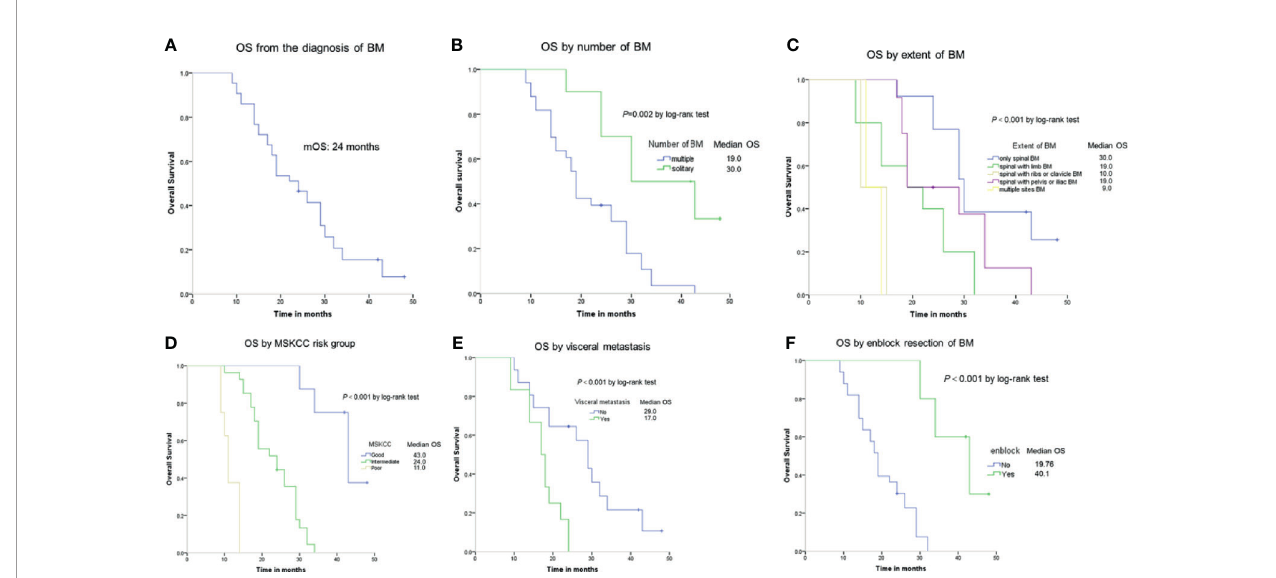
FIGURE 2 | Kaplan-Meier estimates of overall survival (OS) among RCC patients with spinal BM (A) and the OS according to number of sBM (B) , extent of sBM (C) , MSKCC risk group (D) , visceral metastasis (E) , and en-block resection (F) .